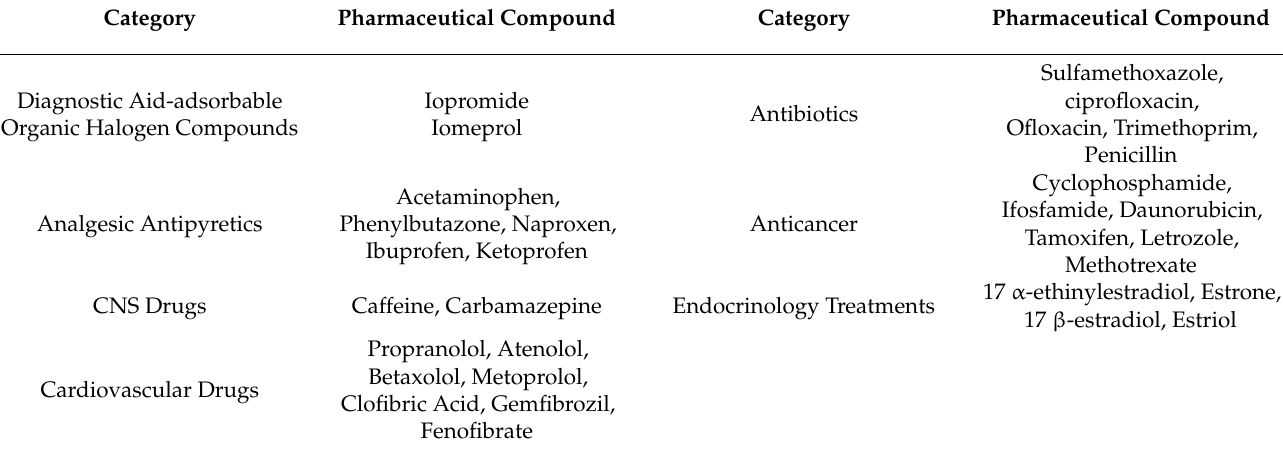
Table 2. Some of the common pharmaceuticals found in wastewater